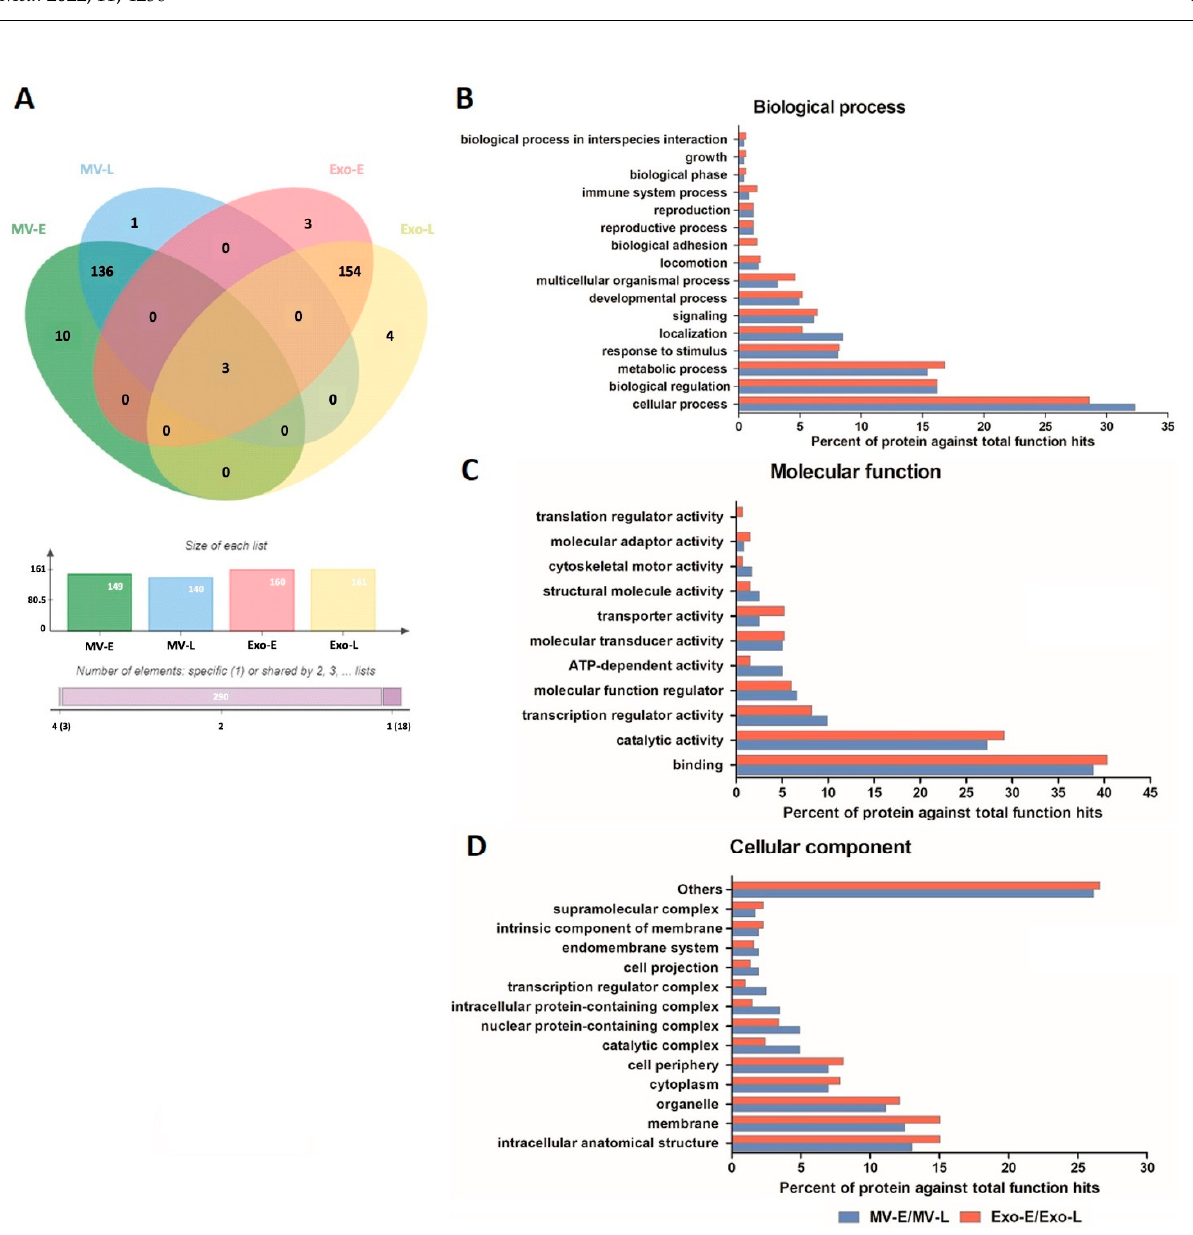
Figure 2. Human proteins in Pf -EVs of different type and developmental stage (MV-E, MV-L, Exo-E, and Exo-L). ( A ) Venn diagram showing the proteins differentially expressed in each type of Pf -EVs. The column graph presents the number of proteins in each type of EVs, and the bar graph indicates the number of proteins shared between types of EV. ( B – D ) GO annotation analyses of the common proteins in MV (MV-E/MV-L) and Exo (Exo-E/Exo-L); ( B ) biological process, ( C ) molecular function, and ( D ) cellular component.